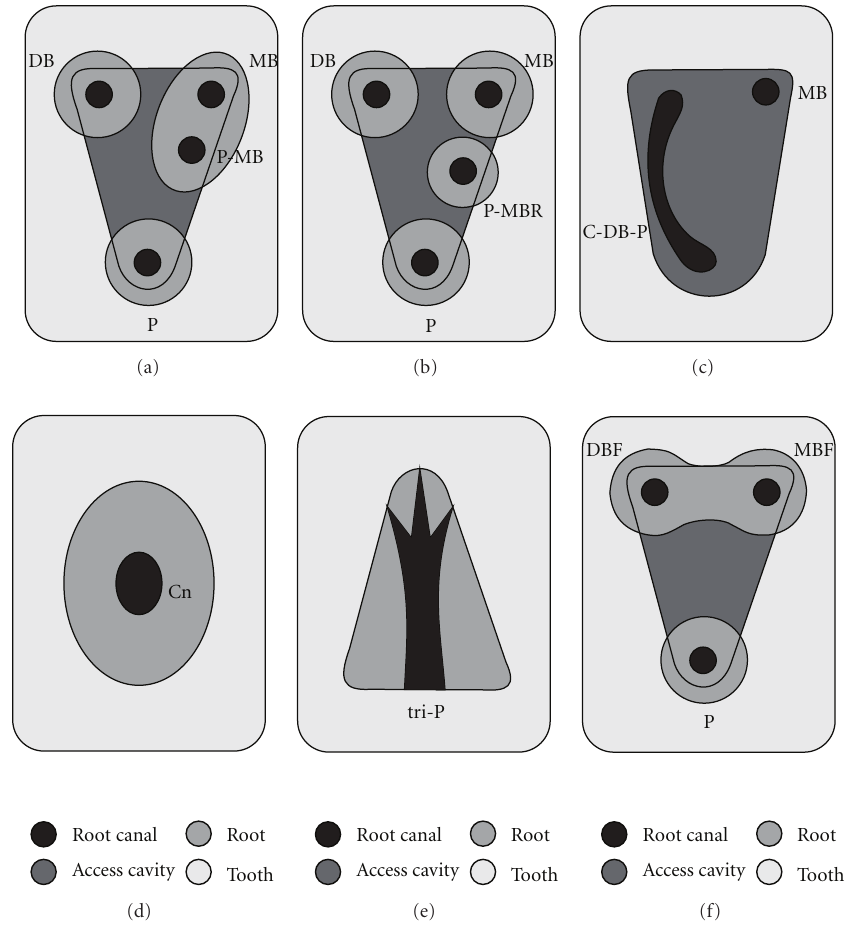
Figure 2: Diagrammatic representations of the various root and canal configurations in maxillary molars named according to the proposed nomenclature. (a) Names of the canals will not be altered if all canals are located in their respective principle roots; MB: mesiobuccal, P-MB: palate-mesiobuccal, DB: distobuccal, and P: palatal. (b) Presence of a palatally located additional root alters the naming of the canals to signify the additional root by use of the su ffi x “R.” P- MBR signifies a palato -mesiobuccal canal in a palato -mesiobuccal root. (c) Maxillary molar with a C-shaped canal involving the DB and P canals which is denoted as C-DB-P . (d) Maxillary molar with a single root and a central canal denoted as Cn . (e) Illustration of the palatal root section of a palatal canal with a trifurcation, denoted as tri-P . (f) Maxillary molar with fused buccal roots containing distinct MB and DB canal denoted by addition of the letter F to the names of the canals in the fused root, that is, MB F , and DB F